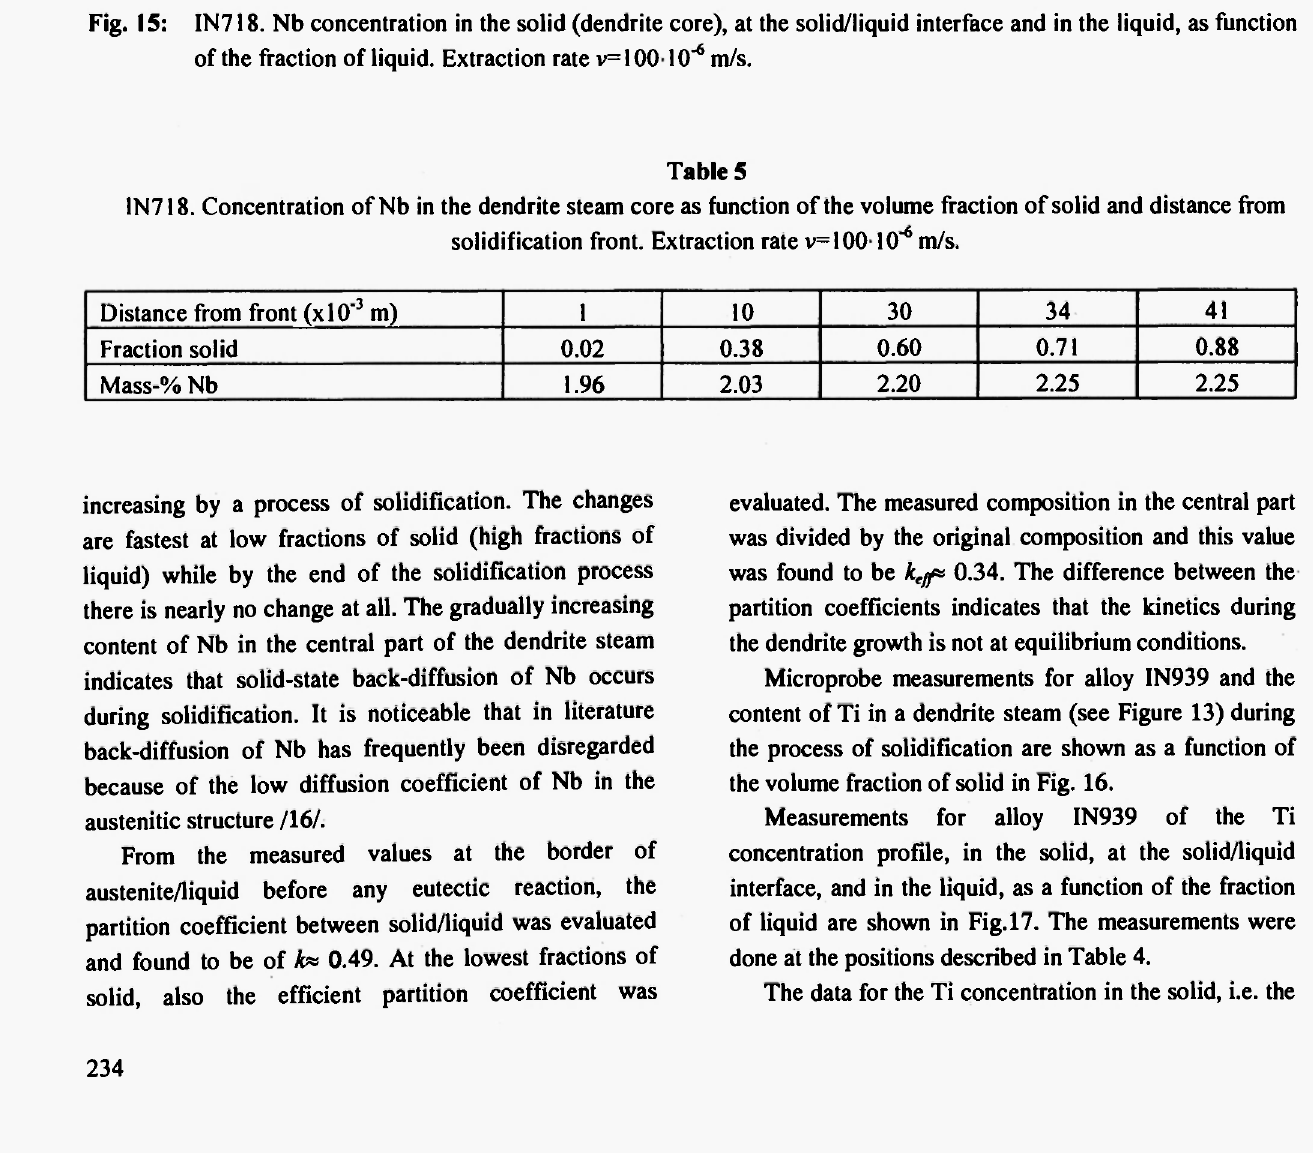
1N718. Concentration of Nb in the dendrite steam core as function of the volume fraction of solid and distance from solidification front. Extraction rate v=10010" 6